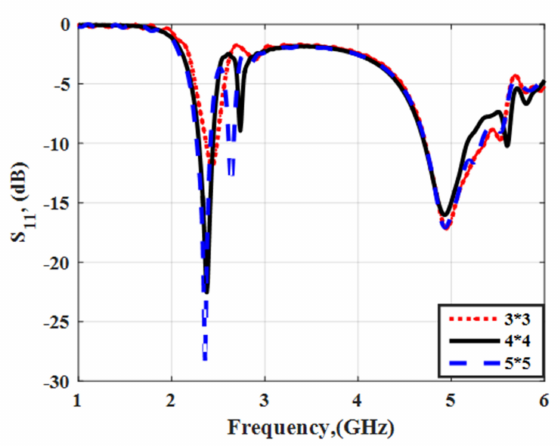
Figure 11. Simulated S 11 results of the proposed antenna with different AMC structure